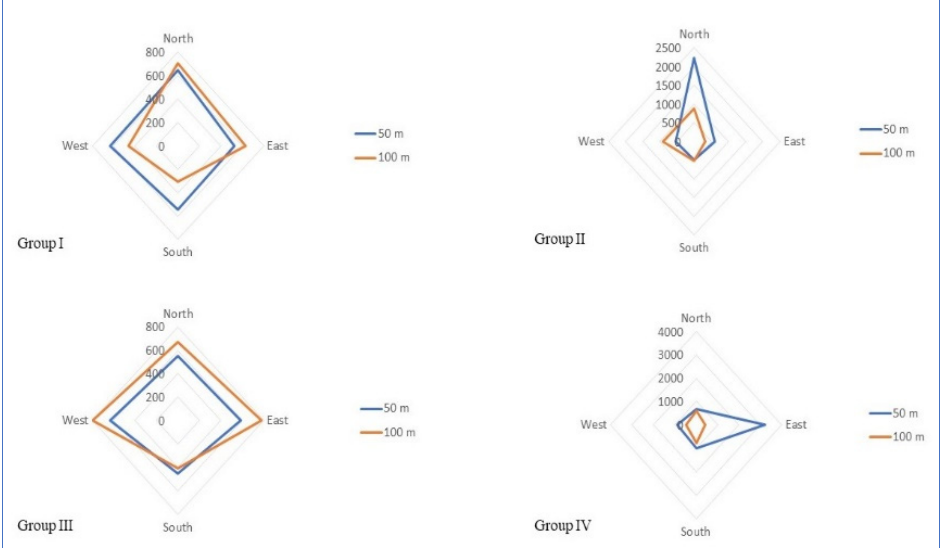
Figure 3. Radar chart showing electric field strength distribution around cell phone towers among different study groups.